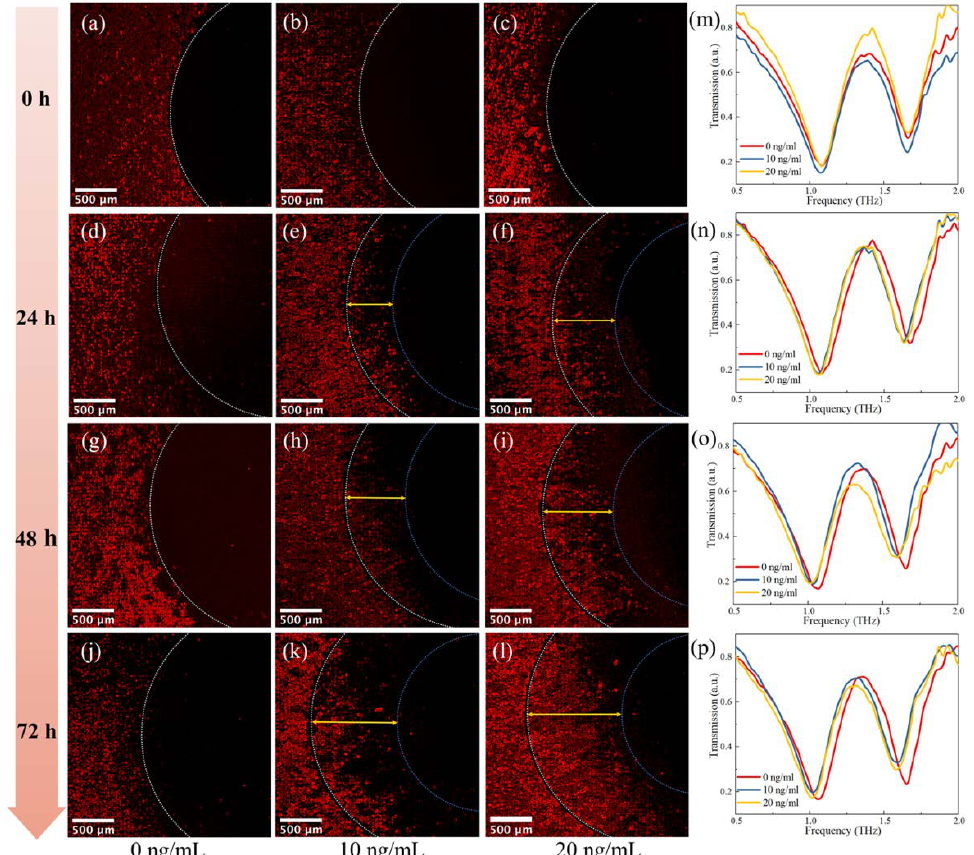
Figure 7. The cell migration behavior of MDA − MB − 231 in response to different concentrations of TGF − β . ( a – l ) Fluorescence pictures of the biosensor under different concentrations of TGF − β for 0, 24, 48, and 72 h. ( m – p ) The transmission spectra of biosensor under TGF − β for 0, 24, 48, and 72 h.